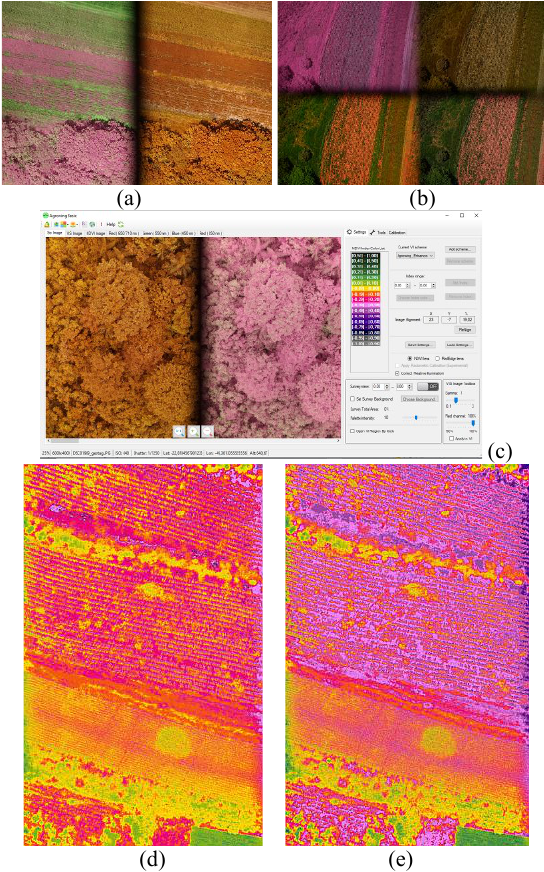
Figure 2. (a) Original frame collected with an Agrowing dual head. (b) 4 head camera (c) software screen; (d) and (e) images with NDVI and SAVI indexes;